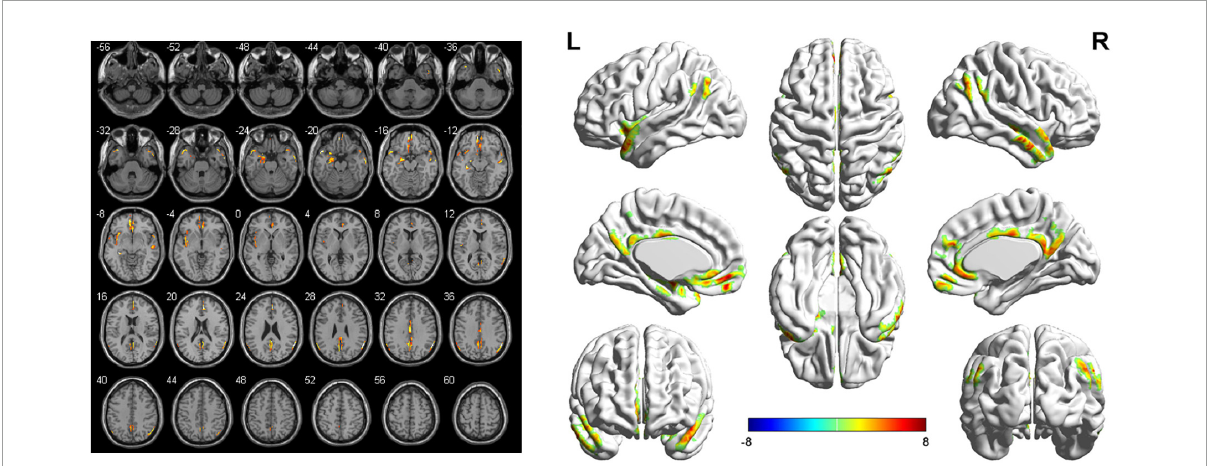
FIGURE1 Left-side SFGmed-based resting-state functional connectivity analysis between patients with ruptured ACoA aneurysm and healthy controls. Results were displayed in 2D (left) and 3D (right) , respectively. The color bar represents T-scores. Brain regions labeling with color indicate decreased functional connectivity in patients with ruptured ACoA aneurysm as compared to the healthy controls. The threshold for displaying was set to p < 0.05, false discovery rate corrected, and cluster size > 50. Details of these color regions are given in Table 2 . SFGmed, medial superior frontal gyrus; ACoA, anterior communicating artery; L, left; R, right.